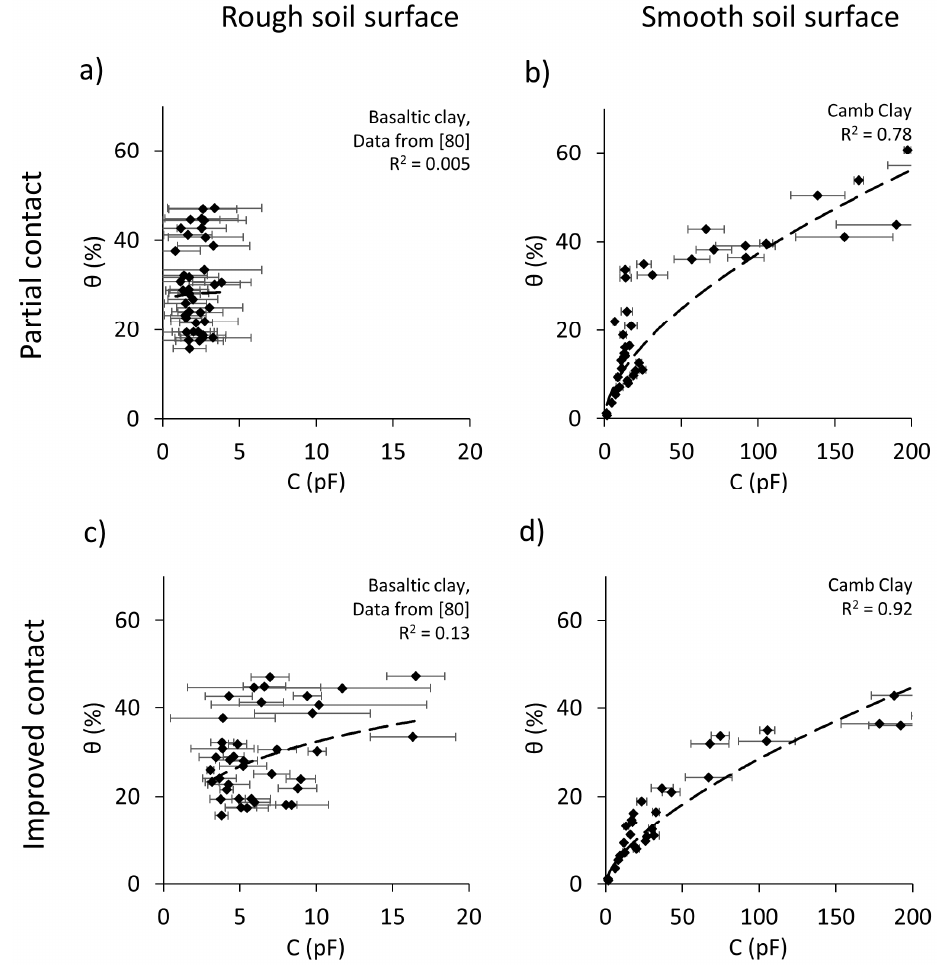
Figure 12. Effect of soil surface roughness and sensor contact on the performance of sensors for two clay samples: Basaltic Clay and Camb Clay samples. Basaltic Clay data are from Orangi, Withers, Langley and Narsilio [80].